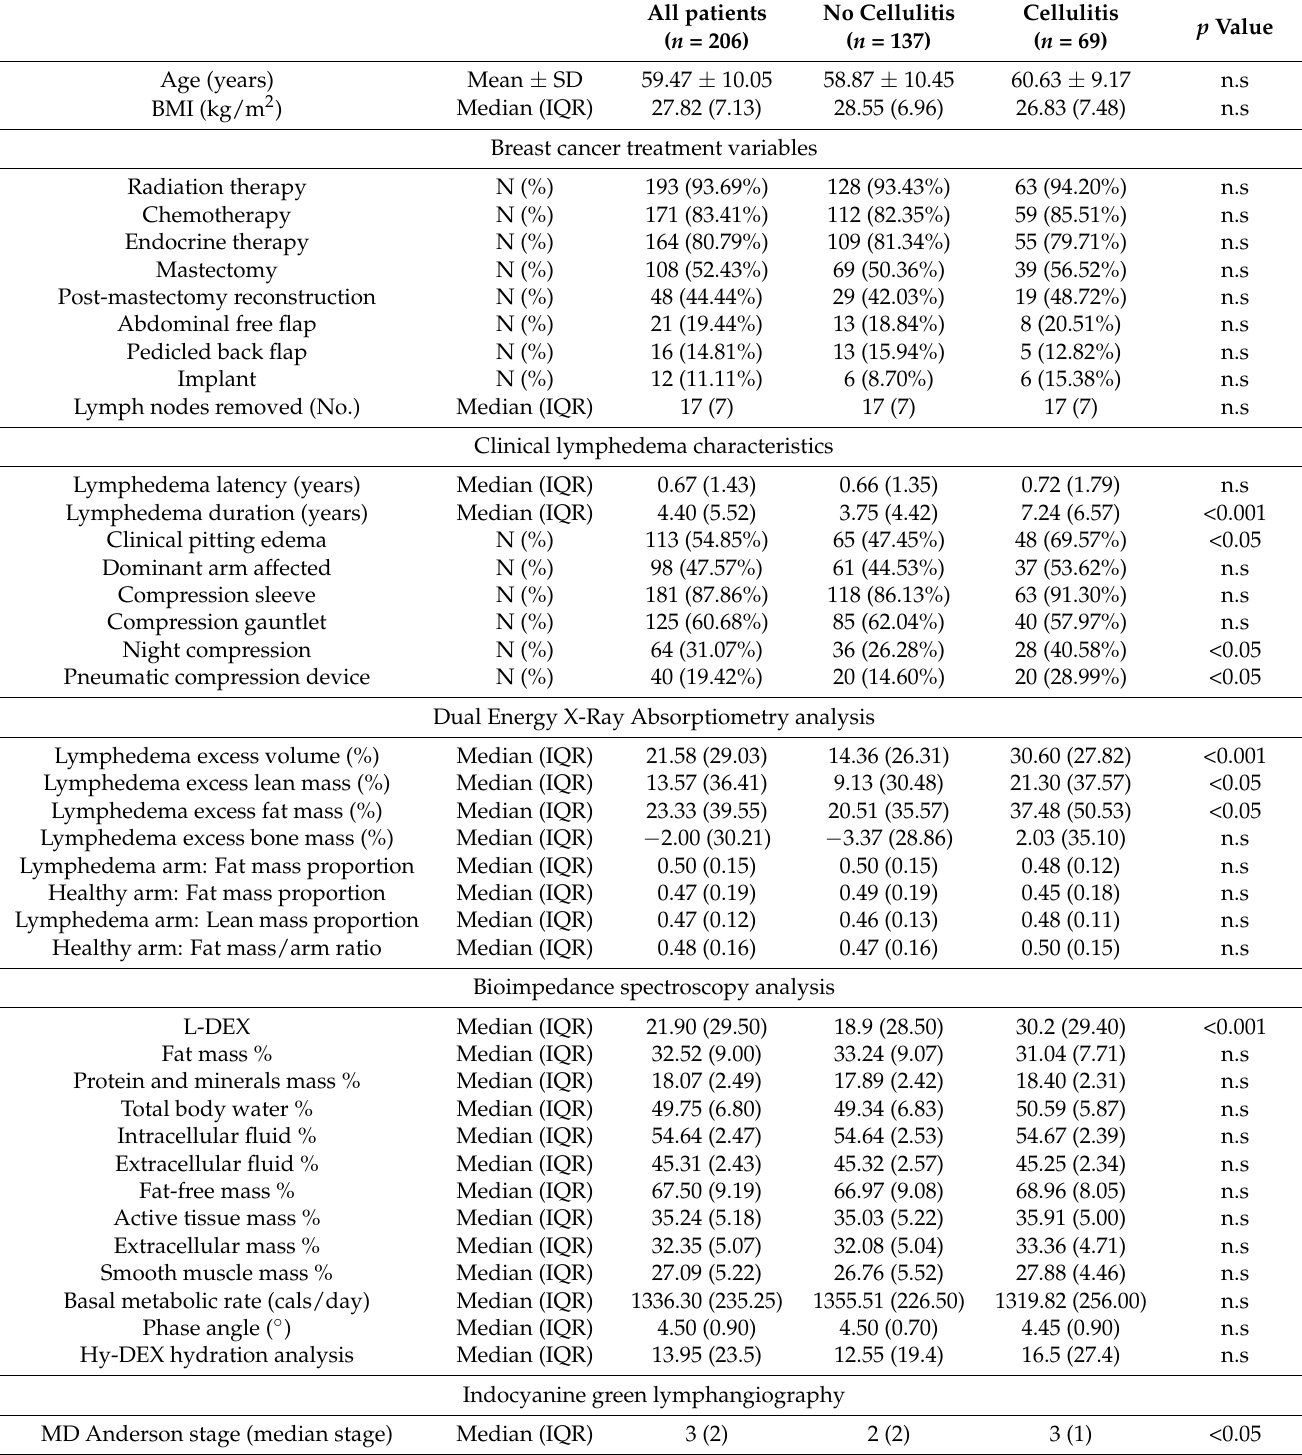
Table 1 legend: This table shows the demographics of the included patients. IQR = interquartile range. n.s = not significant. Comparisons between patients with and without cellulitis were compared using unpaired t-test, Chi-squared, or Mann–Whitney test depending on data type and